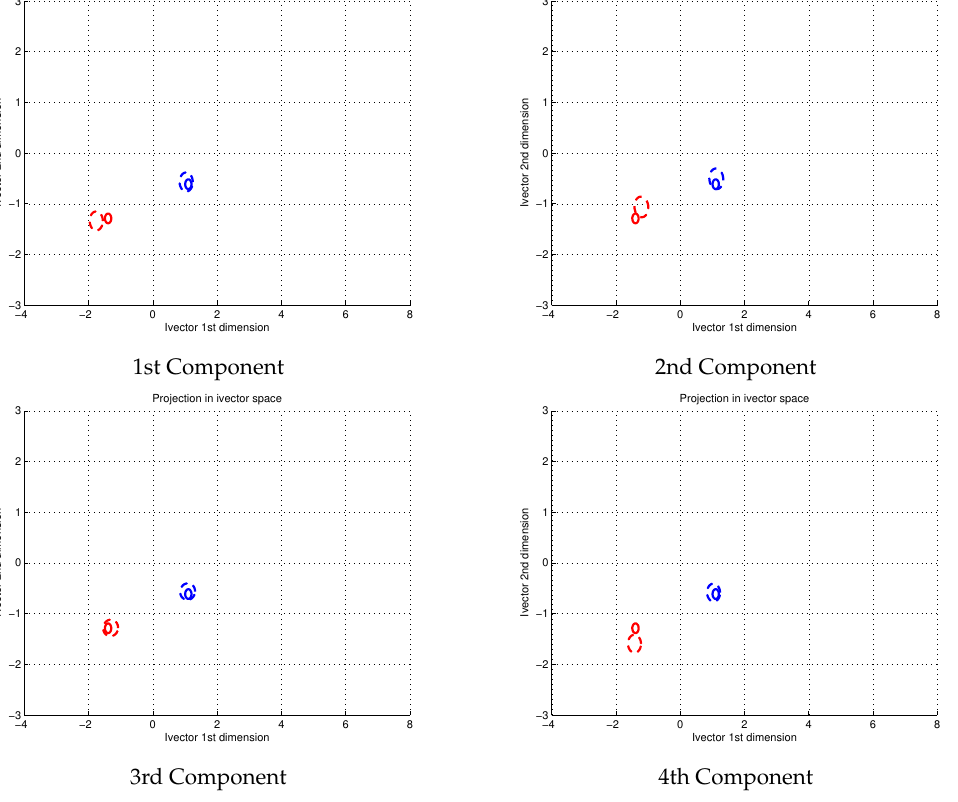
Figure 3. Comparison of posterior distribution of i-vectors with modifications in the phoneme distribution α